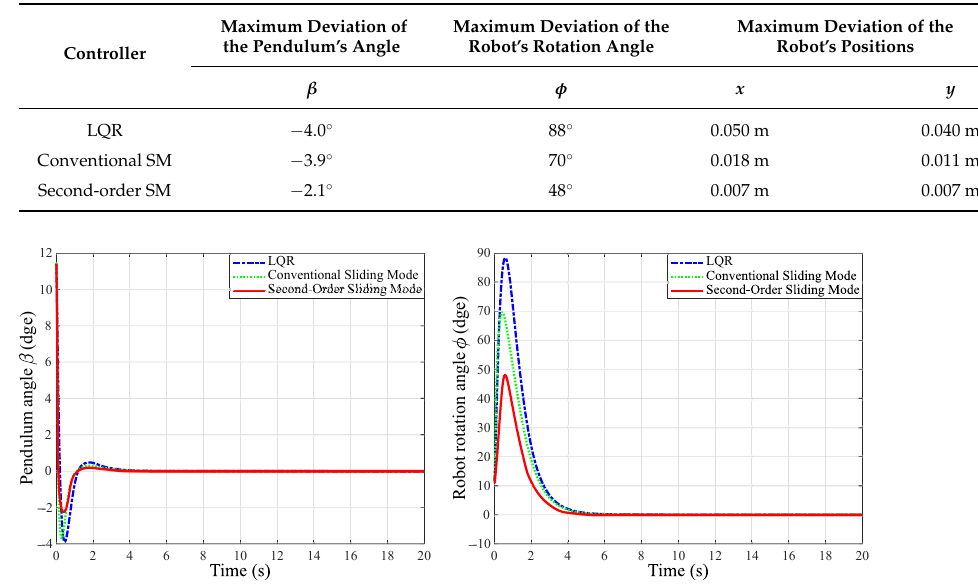
Figure 6. The simulation results compare the angle responses of the inverted pendulum on β and the robot on φ , respectively.